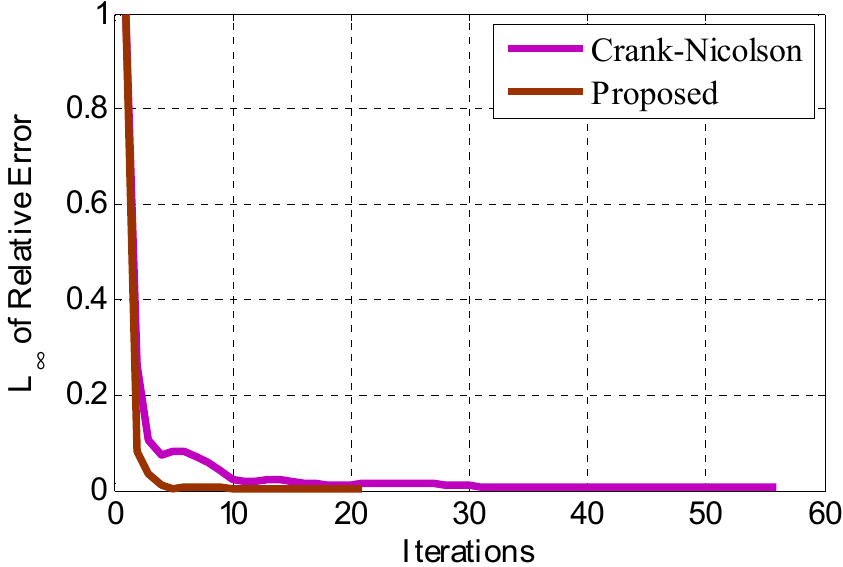
Figure 7. Comparison of speed of convergence of two schemes for Stokes second problem using 𝑀 = 0, 𝑁 = 0, 𝑁 (cid:3051) = 40,𝑁 (cid:3047) = 200, 𝐿 = 17, 𝑡 (cid:3033) = 10 .